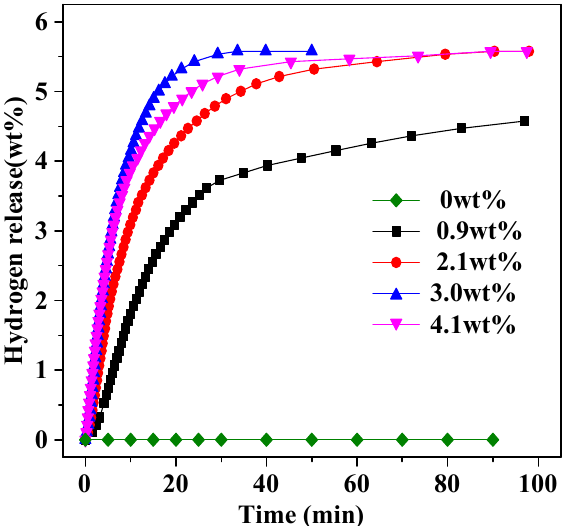
Figure 4. Hydrogen release from dodecahydro-N-ethylcarbazole catalyzed by Pd/CNTs with different Pd loadings at 513 K.